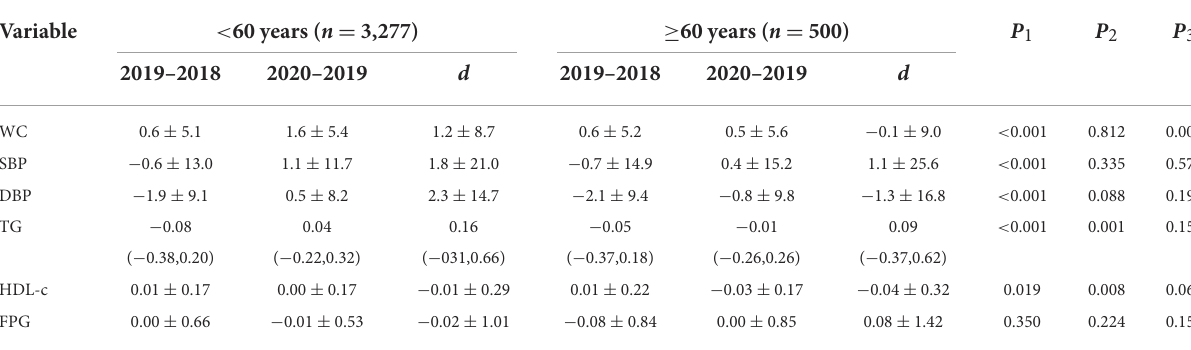
TABLE 6 The impact of the COVID-19 lockdown on MetS components indicators in different age groups. Variable < 60 years ( n =